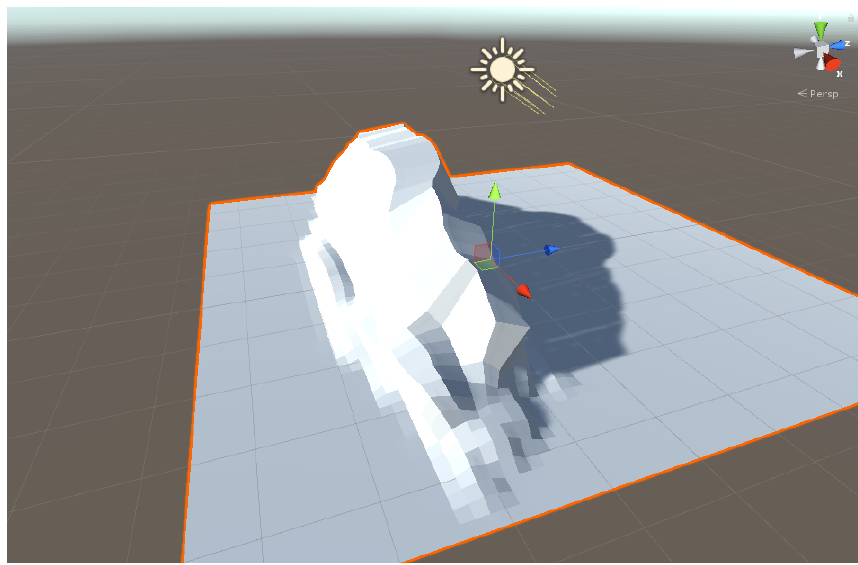
Figure 20. Self-shadow representation with Unity engine.